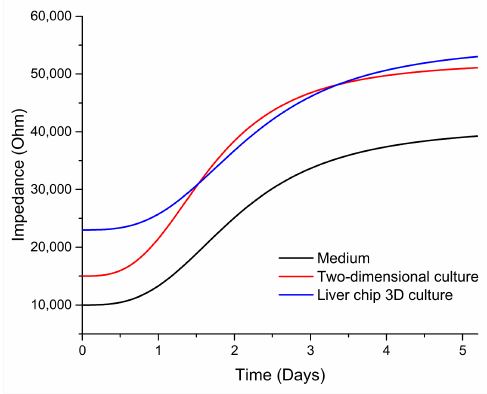
Figure 3. Impedance monitoring in di ff erent culture